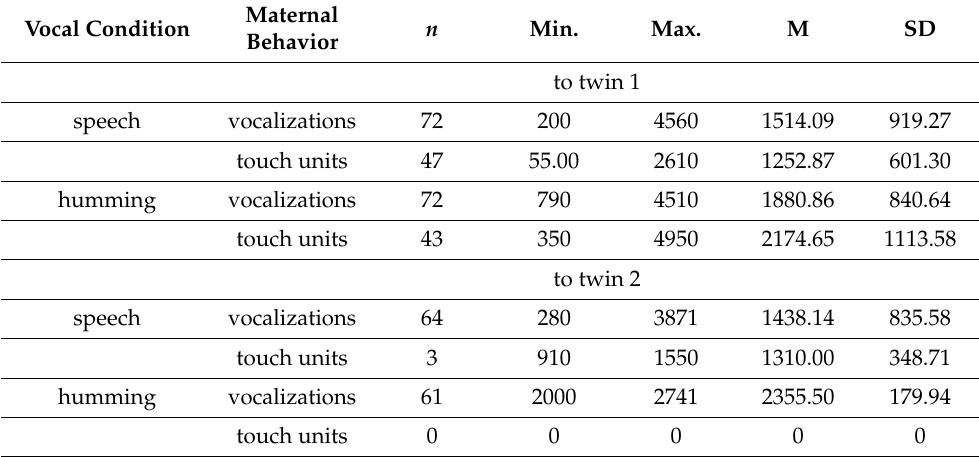
Table 1. Descriptive analysis of the lengths (ms) of maternal vocalizations (phrases) and of touch units in speech or humming to twin 1 and to twin